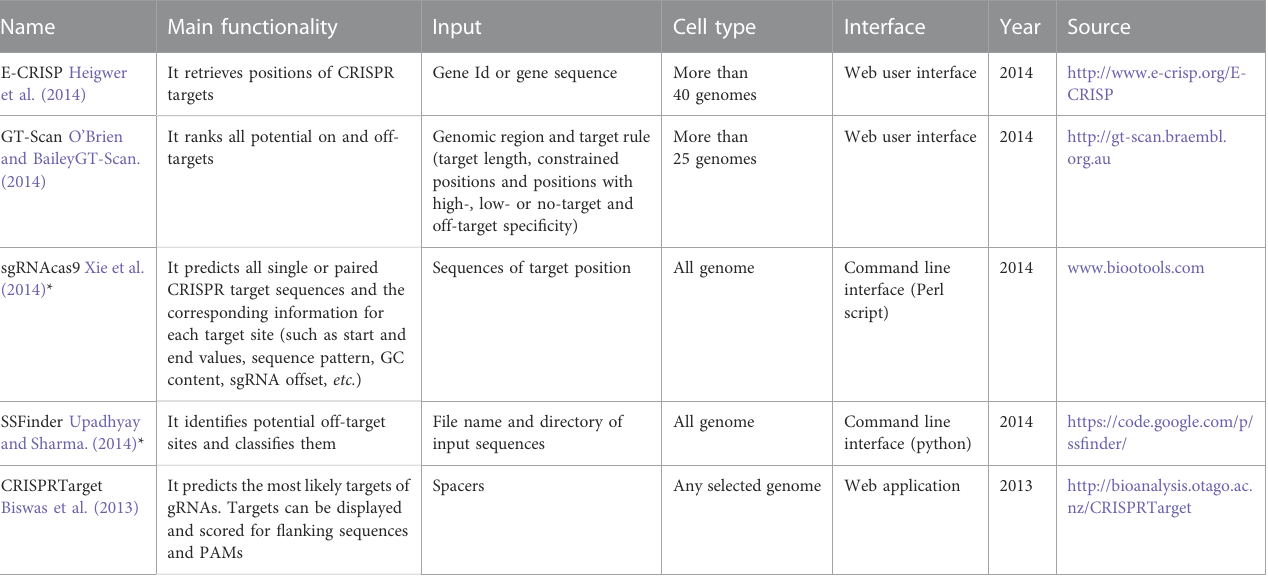
TABLE 2 ( Continued ) Tools and software packages related to fi nding off-target